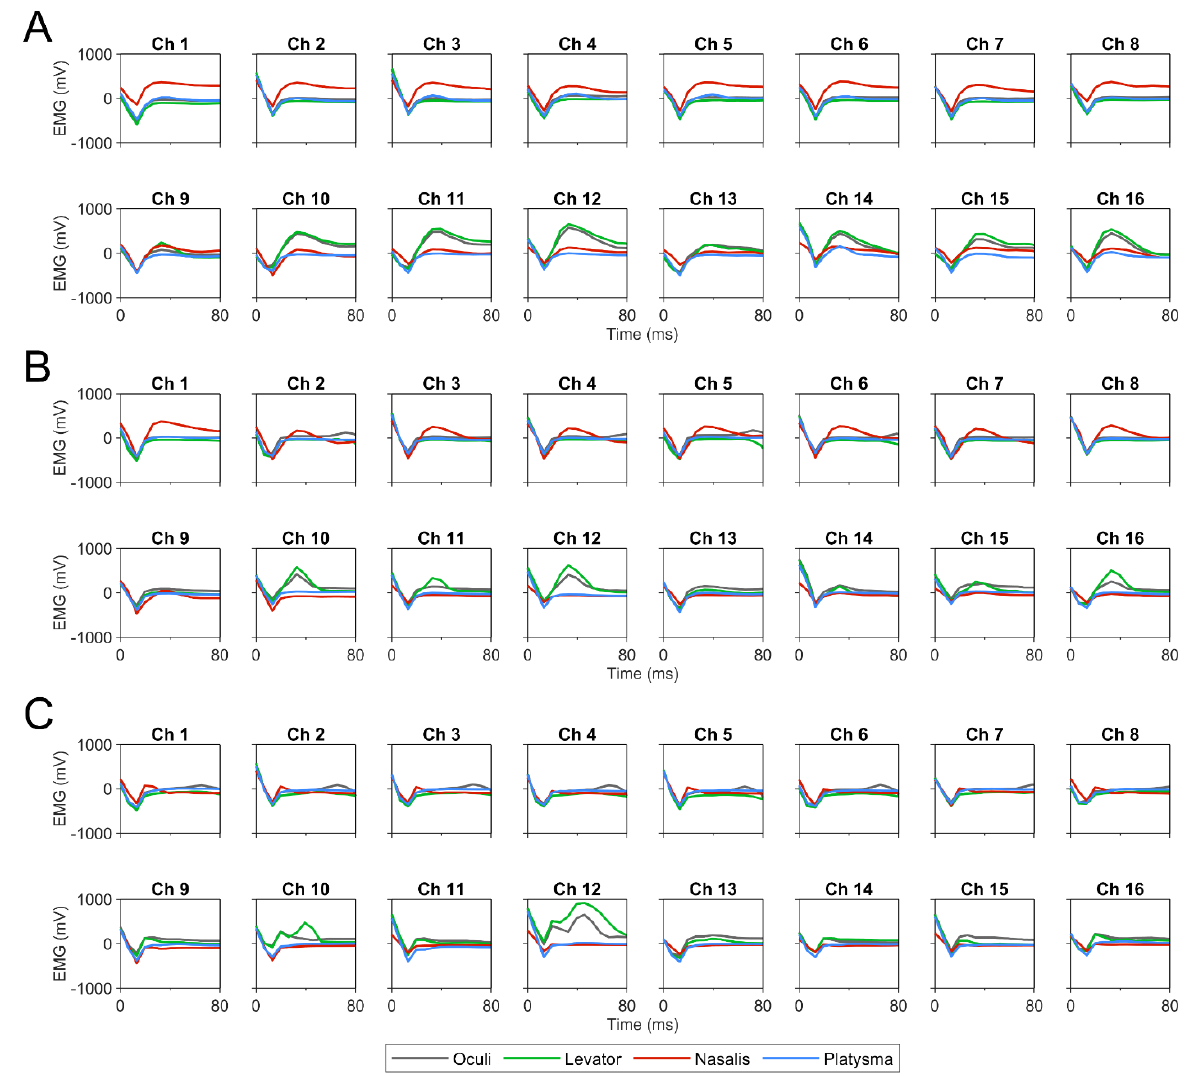
Figure 2. EMG waveforms 6 months post-implantation from four electrically stimulated facial muscles at ( A ) 15, ( B ) 30, and ( C ) 60 µ A across 16 channels. Channels 1–8 represented MCE 1 on the lower FN branch. Channels 9–16 represented MCE 2 on the upper FN branch. Stimulation occurred at t = 0 ms.